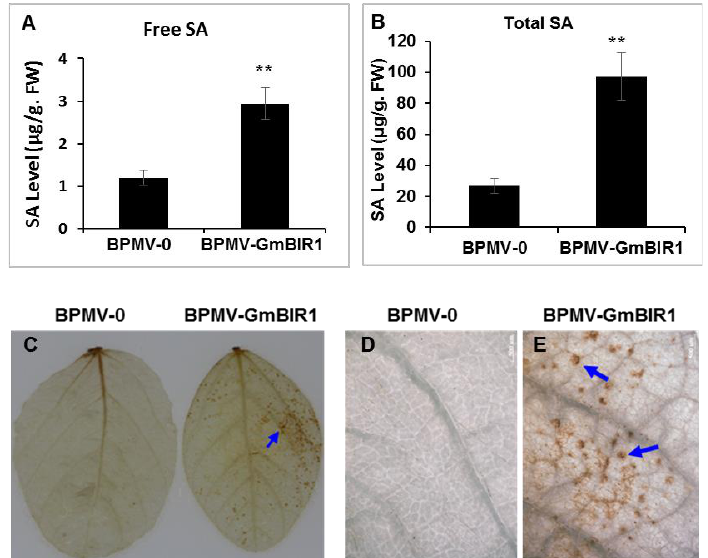
Figure 2. Elevated accumulation of SA and H 2 O 2 in GmBIR1 -silenced plants. ( A , B ) Free SA ( A ) and Total SA ( B ) levels were quantified in GmBIR1 -silenced and BPMV-0 empty vector control plants at 20 days post BPMV inoculation. Error bars represent SD for three independent samples. Asterisks indicate significant differences from the control (**, p < 0.01, Student’s t test). FW, fresh weight. ( C ) Presence of H 2 O 2 in soybean leaves visualized by staining with DAB. ( D , E ) The images taken under the stereomicroscope from part of the regions shown in C, Bar = 500 µ m. Oxidized DAB formed a reddish-brown deposit. (Examples of these deposits are indicated by the blue arrows).